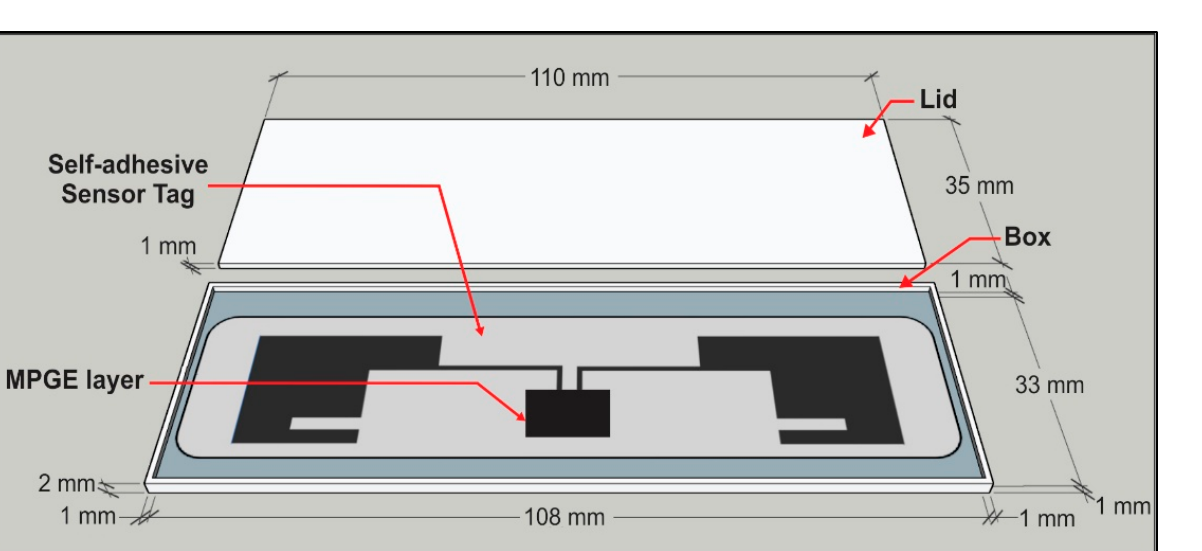
Figure 5. A 3 mm-deep 3D-printed case.